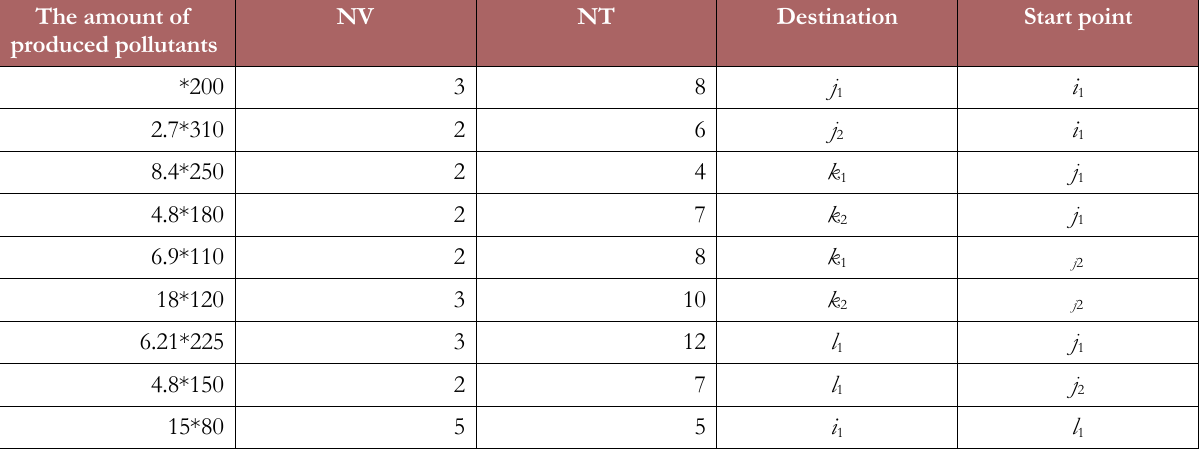
Table 2. the amount of pollutants generated in the queues of each center due to the queue